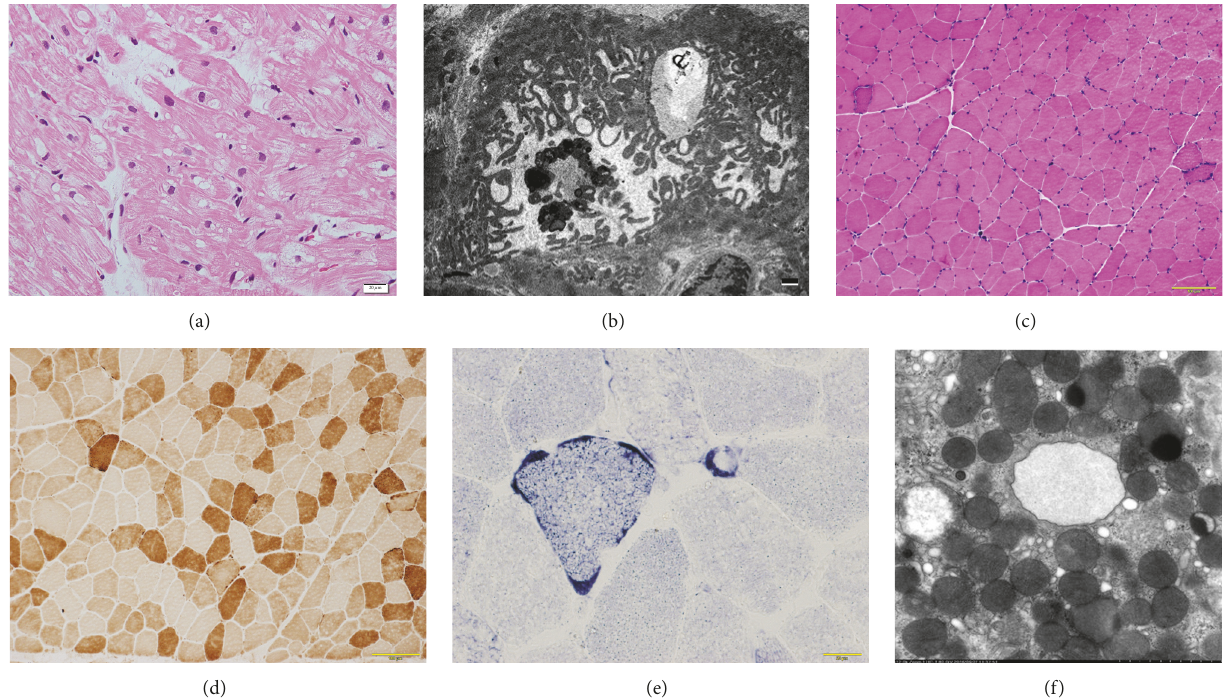
Figure 2: (a) Light micrographs from endomyocardial biopsy revealed vacuolar change in myocardial cells, especially around nucleus and perimysial fibrosis without inflammatory cells (hematoxylin eosin stain, bar: 20 𝜇 m). (b) Electron microscopic examination of the endomyocardial biopsy revealed mitochondrial deformations with various types (e.g., sausage-like, loop-like, small, or gigantic), bar: 1 𝜇 m. (c) Light micrographs of the muscle biopsy revealed ragged red fibers (hematoxylin eosin stain, bar: 100 𝜇 m). (d) Light micrographs of the muscle biopsy revealed decreased cytochrome c oxidase (COX)activity (COXstain, bar: 100 𝜇 m). (e) Light micrographs of the muscle biopsy revealed blood vessels strongly reactive (SSV) to succinate dehydrogenase (SDH) (SDH stain, bar: 100 𝜇 m). (f) Electron microscopic examination of gastric biopsy revealed normal mitochondria ( ×